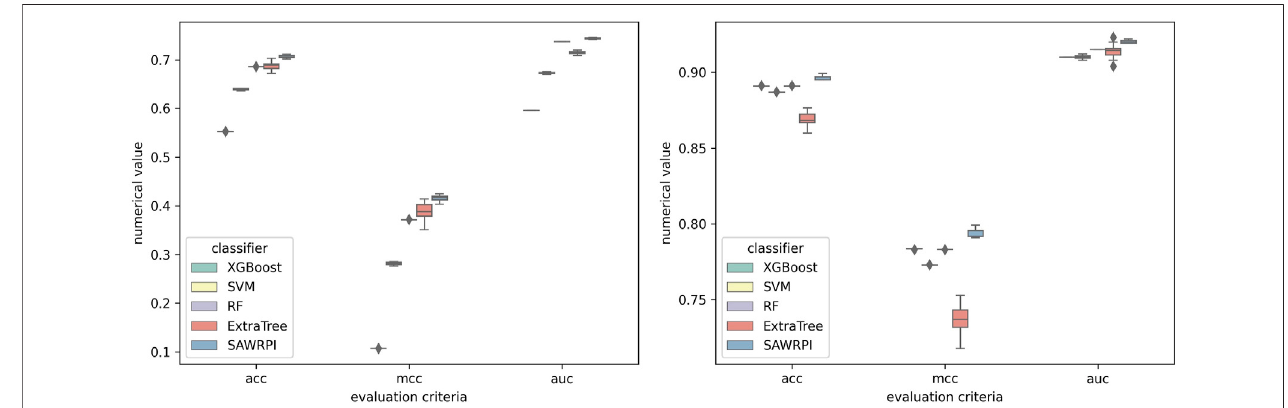
TABLE 6 | Five-Fold cross-validation average results on three feature extracting strategies. Dataset Strategies